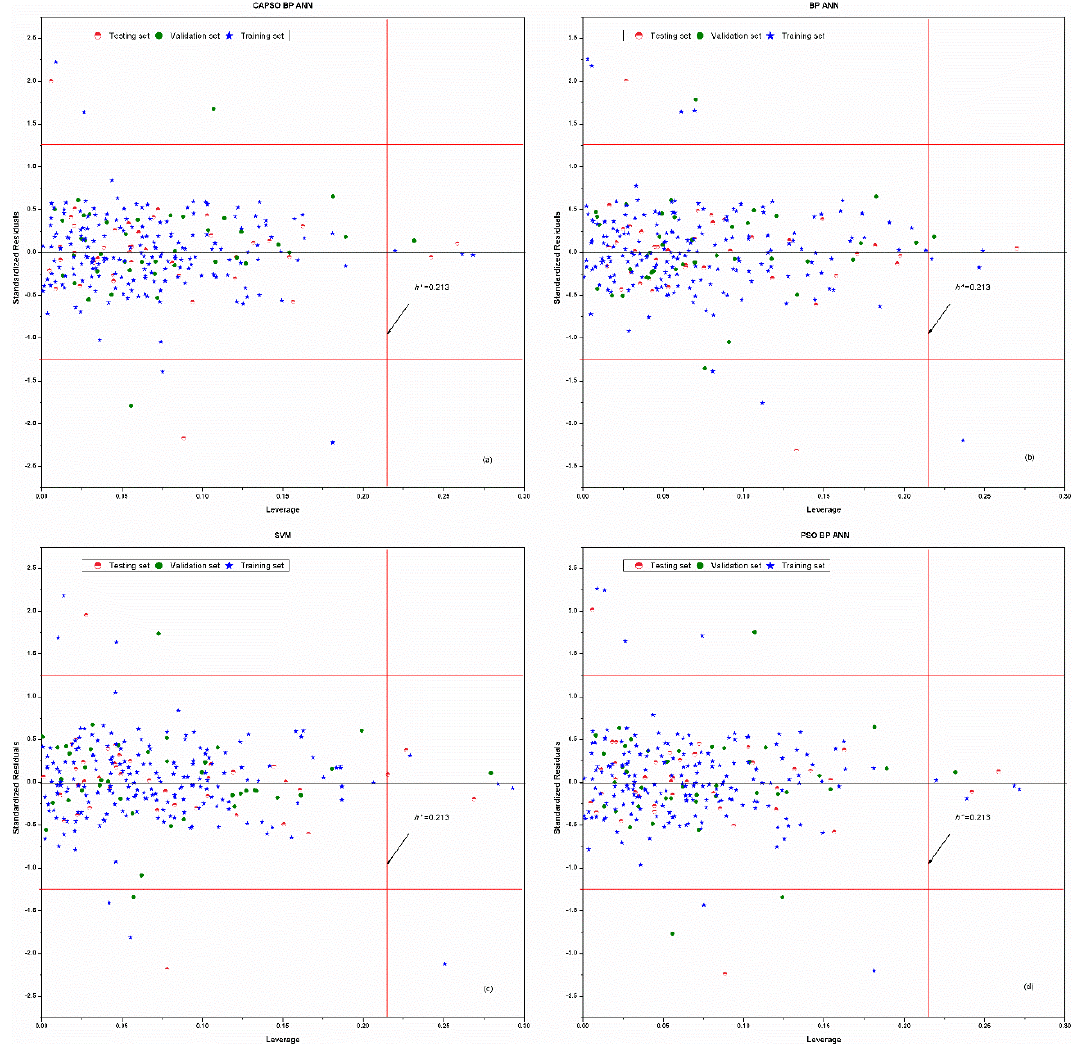
Figure 6. Applicability domain of each model.